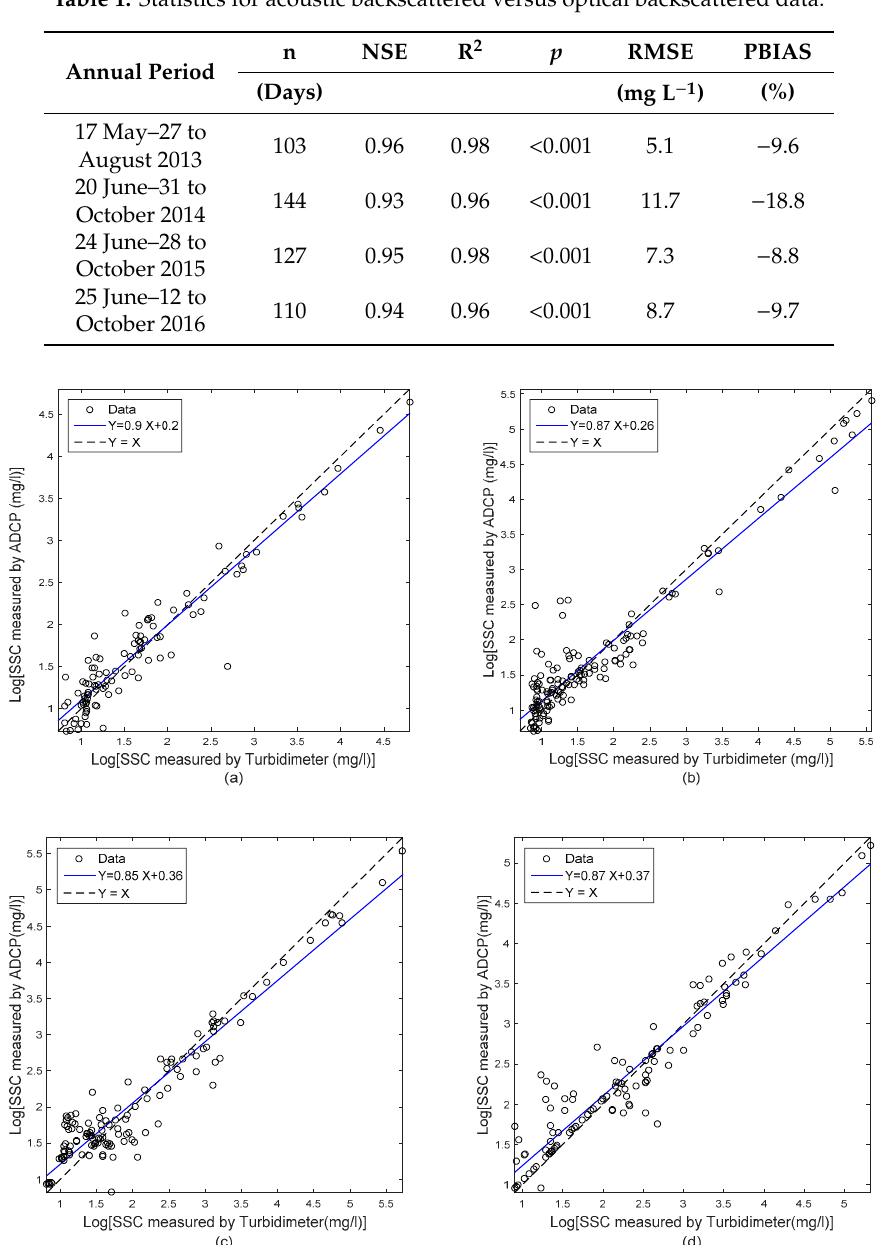
Figure 4. Daily averaged SSC measured by the Sentinel V and YSI probe for summers of 2013 ( a ), 2014 ( b ), 2015 ( c ), and 2016 ( d ).